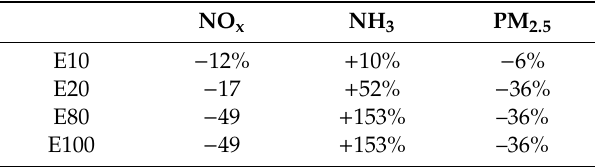
Table 5. NO x , NH 3 and PM 2.5 assumed correction factors.